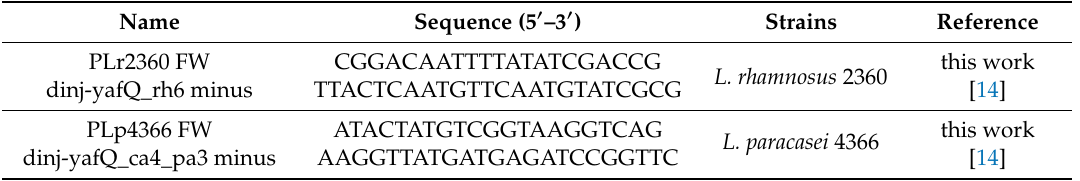
Table 2. Primer pairs used in PCR amplification